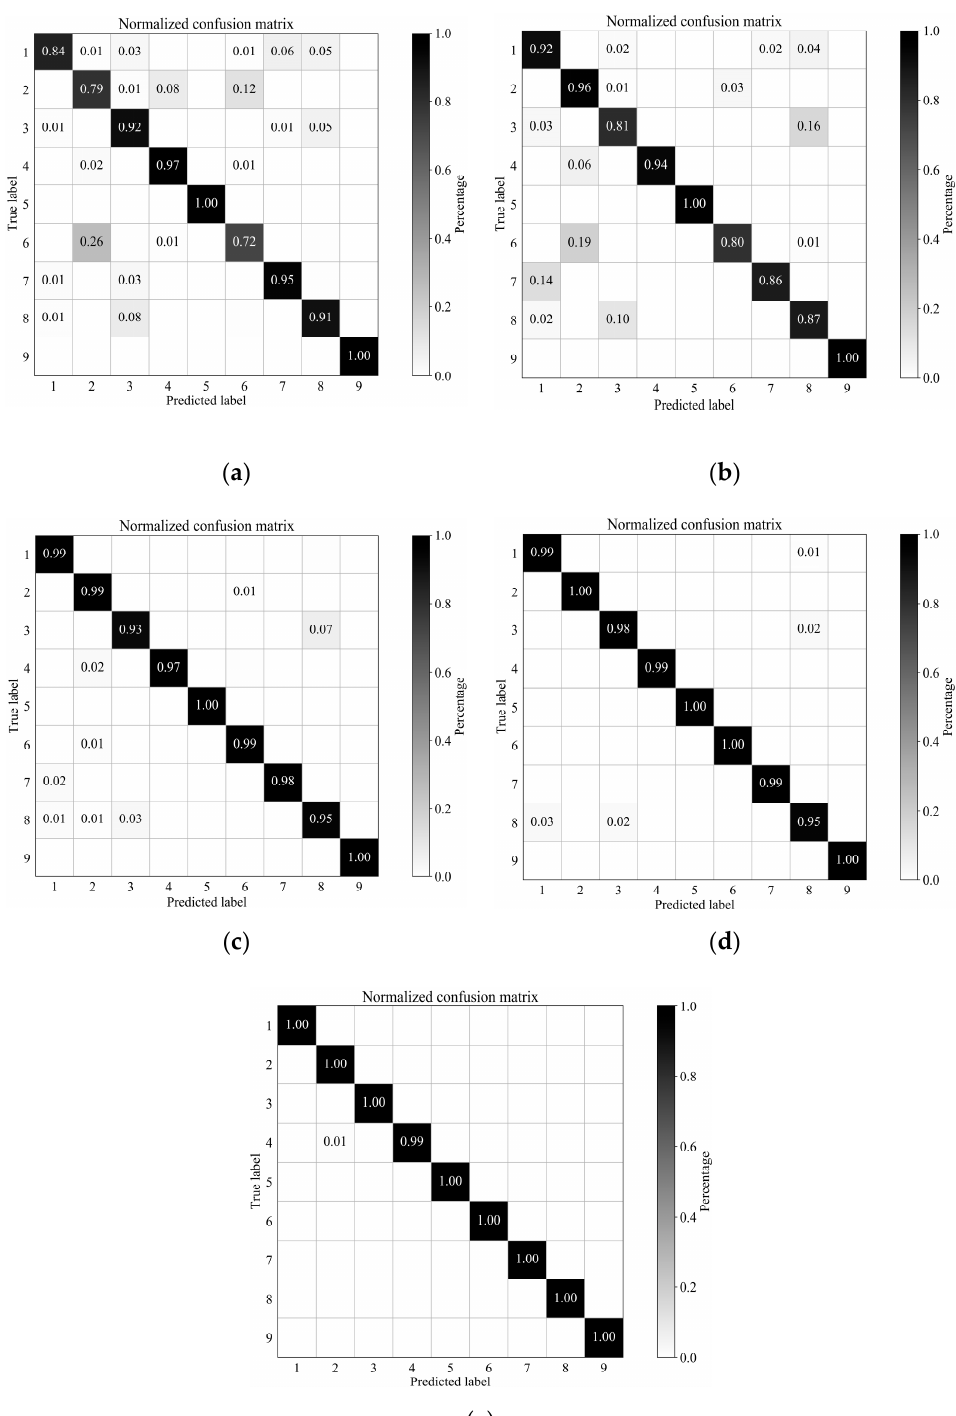
Figure 11. University of Pavia dataset: Normalized confusion matrix of classification results using different methods (displaying value greater than 0.005): ( a ) SSLSTMs, ( b ) 3D CNN, ( c ) FDSSC, ( d ) SSRN, ( e ) SSCC.